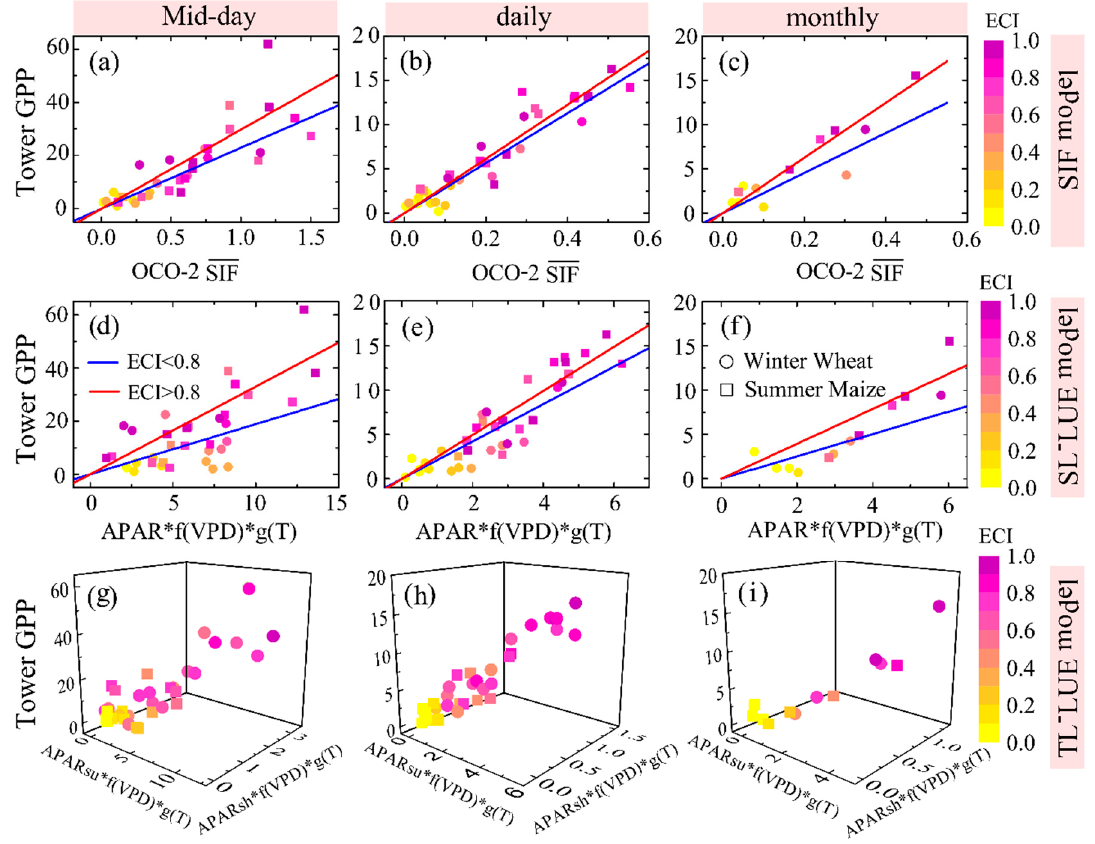
Figure 5. The fluctuations in the parameters of the SIF model and the LUE models for a range of meteorological conditions, where 0.8 is the threshold value at which ECI values are fitted separately. The columns from left to right show the mid-day, daily, and monthly timescales, respectively. The rows from top to bottom indicate the SIF model ( GPP ≈ ε / SIF yield × SIF ), SL-LUE model ( GPP = ε max × APAR × f ( VPD ) × g ( T a ) ), and TL-LUE model ( GPP = ε msu × APAR su × f ( VPD ) × g ( T a ) + ε msh × APAR sh × f ( VPD ) × g ( T a ) ), respectively. The unit of tower GPP is gC m − 2 day − 1 , the unit of OCO-2 SIF is W m − 2 μ m − 1 sr − 1 , and the unit of APAR × f(VPD) × g(T) is MJ m − 2 day − 1 (1 MJ = 10 6 J).